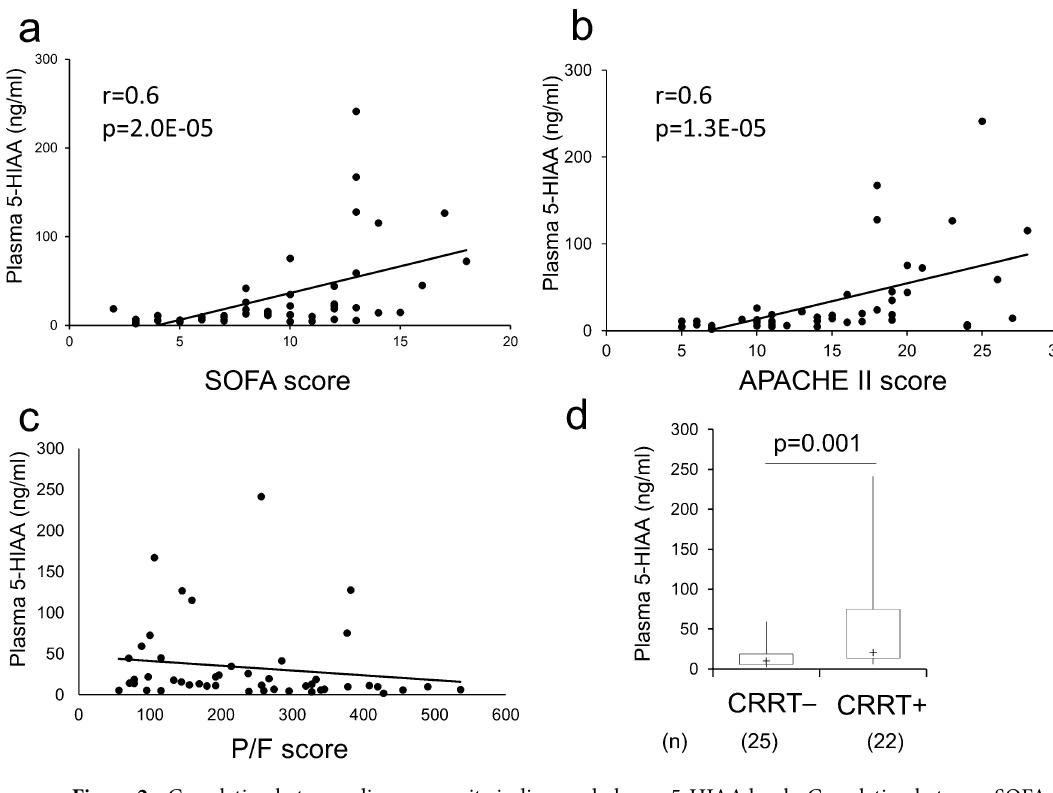
Figure 2. Correlation between disease severity indices and plasma 5-HIAA levels. Correlation between SOFA score and plasma 5-HIAA level ( a ); between APACHE-II score and plasma 5-HIAA level ( b ); and between PaO 2 :FiO 2 ratio and plasma 5-HIAA level ( c ), by Spearman’s correlation test, and the plasma 5-HIAA level difference between sepsis patients without CRRT and sepsis patients with CRRT ( d ) by Mann–Whitney U-test.